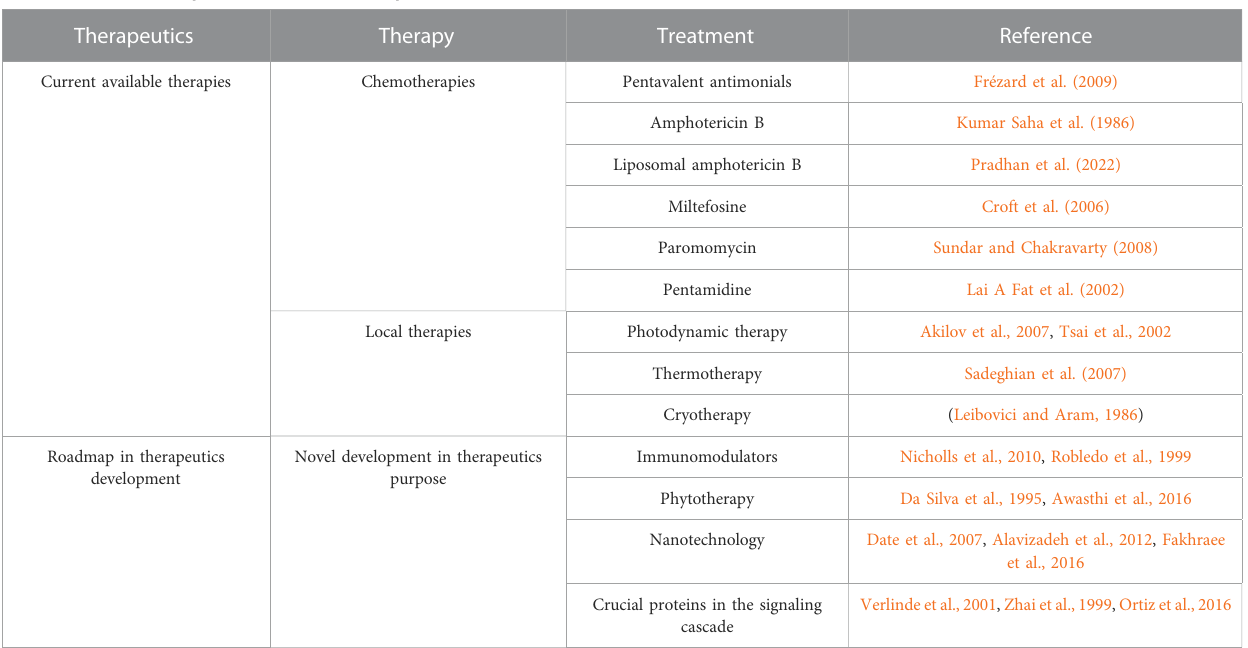
TABLE 1 Available therapeutics and newer development in